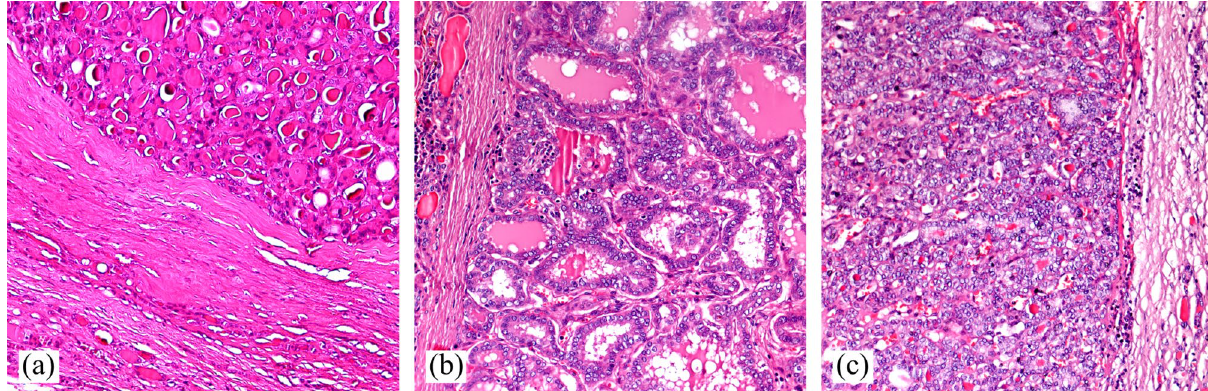
Figure 3. Typical bright-field images acquired on collagen nodule capsules for the cases of ( a ) FA, ( b ) PTC and ( c )